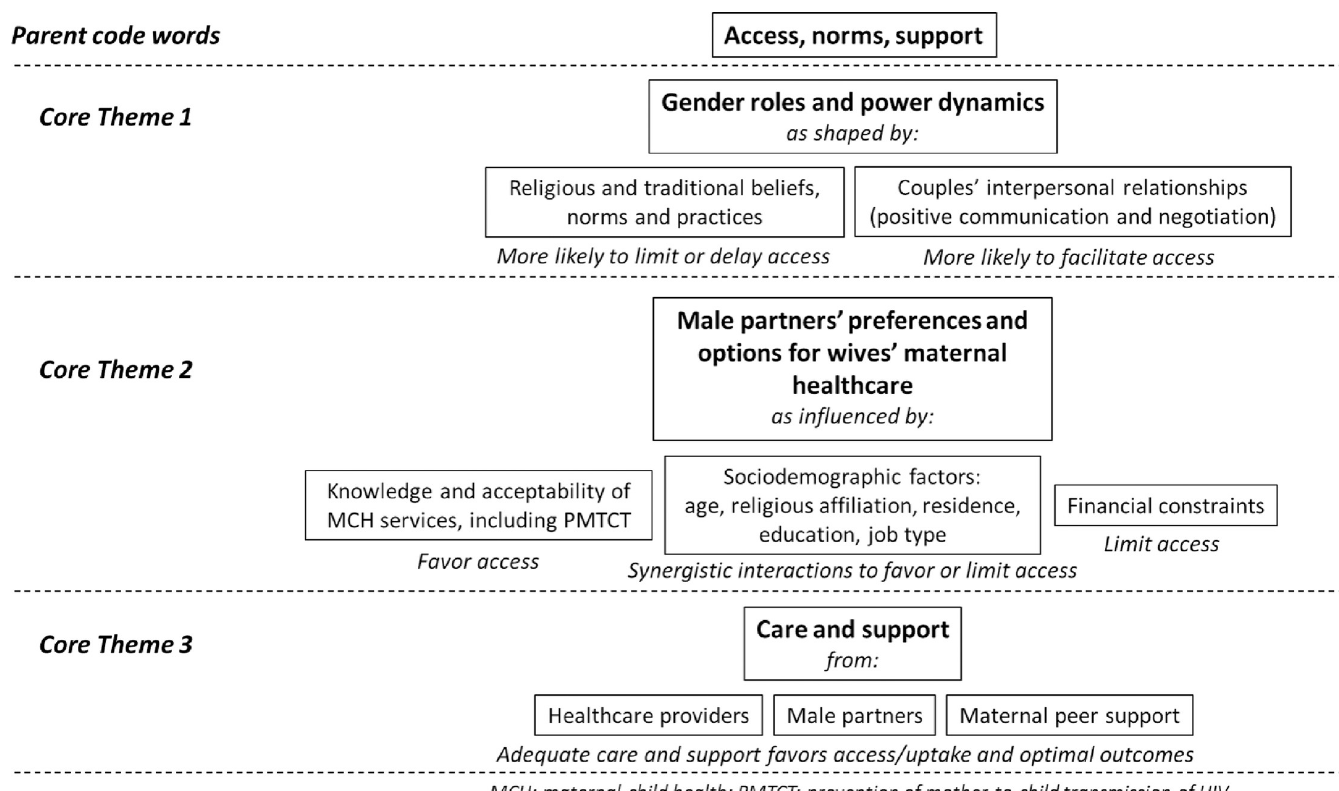
Fig 1. Core themes in women’s access to maternal-child health services from the male partner perspective.